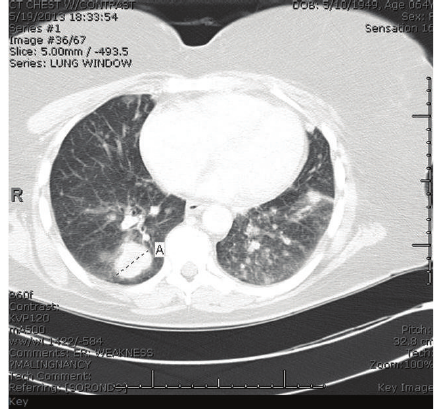
Figure 2: CT of the chest showing bilateral pulmonary nodules.